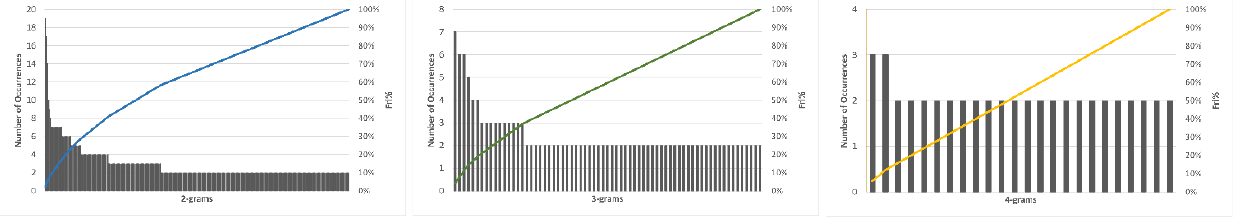
Figure 11. Histograms of the n -grams from IHC: (a) bigram; (b) trigram; (c)